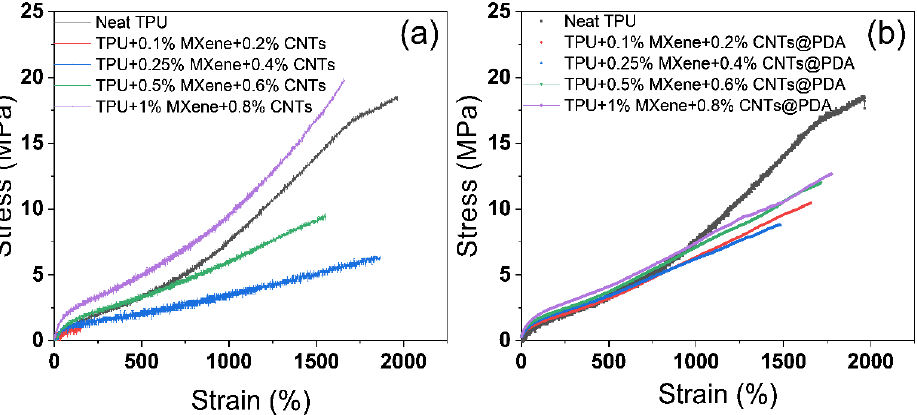
Figure 7. Stress–strain curves for TPU composites containing different fillers. ( a ) MXene/CNTs, ( b ) MXene/CNTs@PDA.